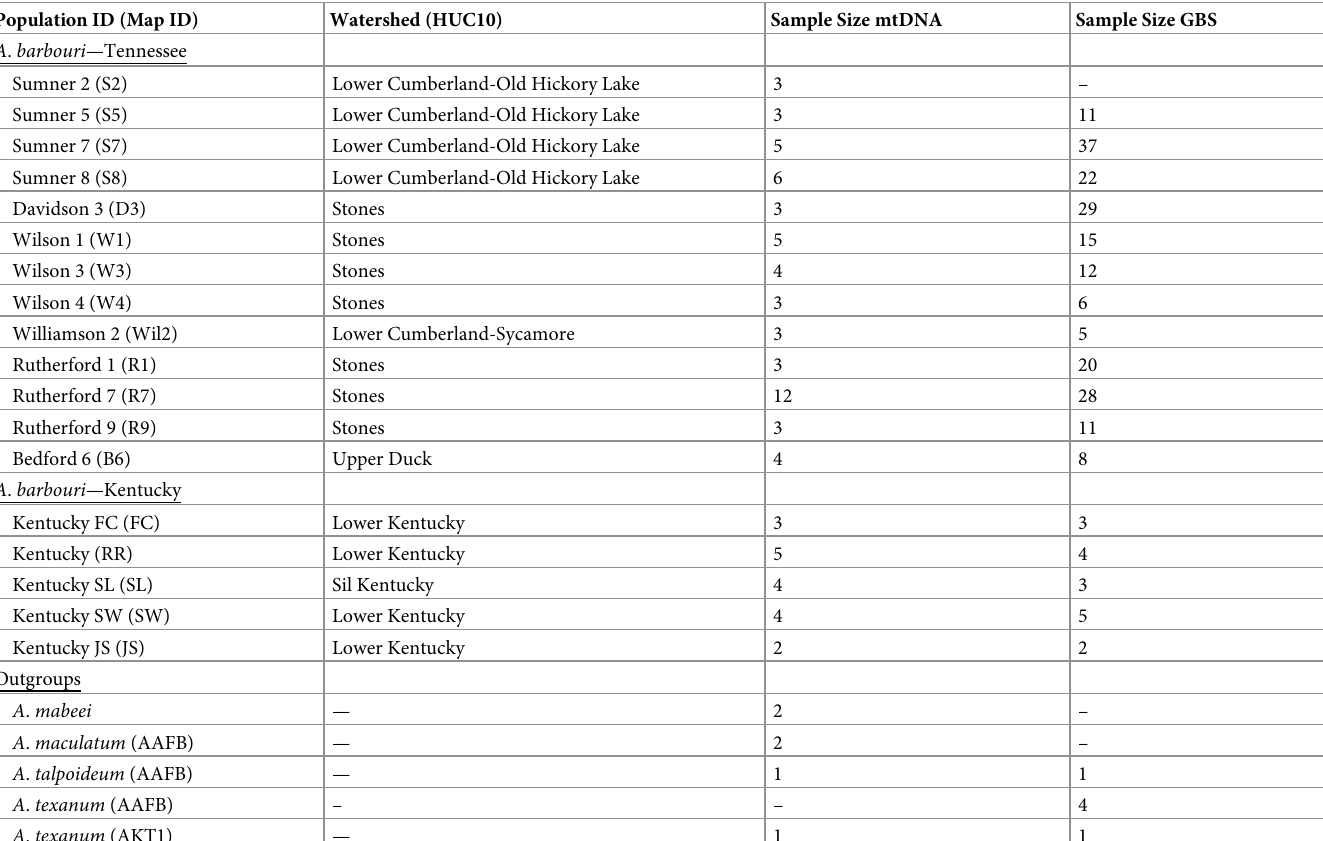
Table 1. Population IDs, sample sizes for mtDNA/GBS analyses, and map coordinates for all populations. Population IDs for A . barbouri collections correspond to map locations in Fig 1. For outgroup samples, AAFB denotes Arnold Air Force Base and AKT1 denotes A . texanum from Arkansas. Population IDs by county are as fol- lows: Bedford County (B6), Davidson County (D3), Rutherford County (R1, R7, and R9), Sumner County (S2, S5, S7, and S8), Wilson County (W1, W3, and W4), and Williamson County